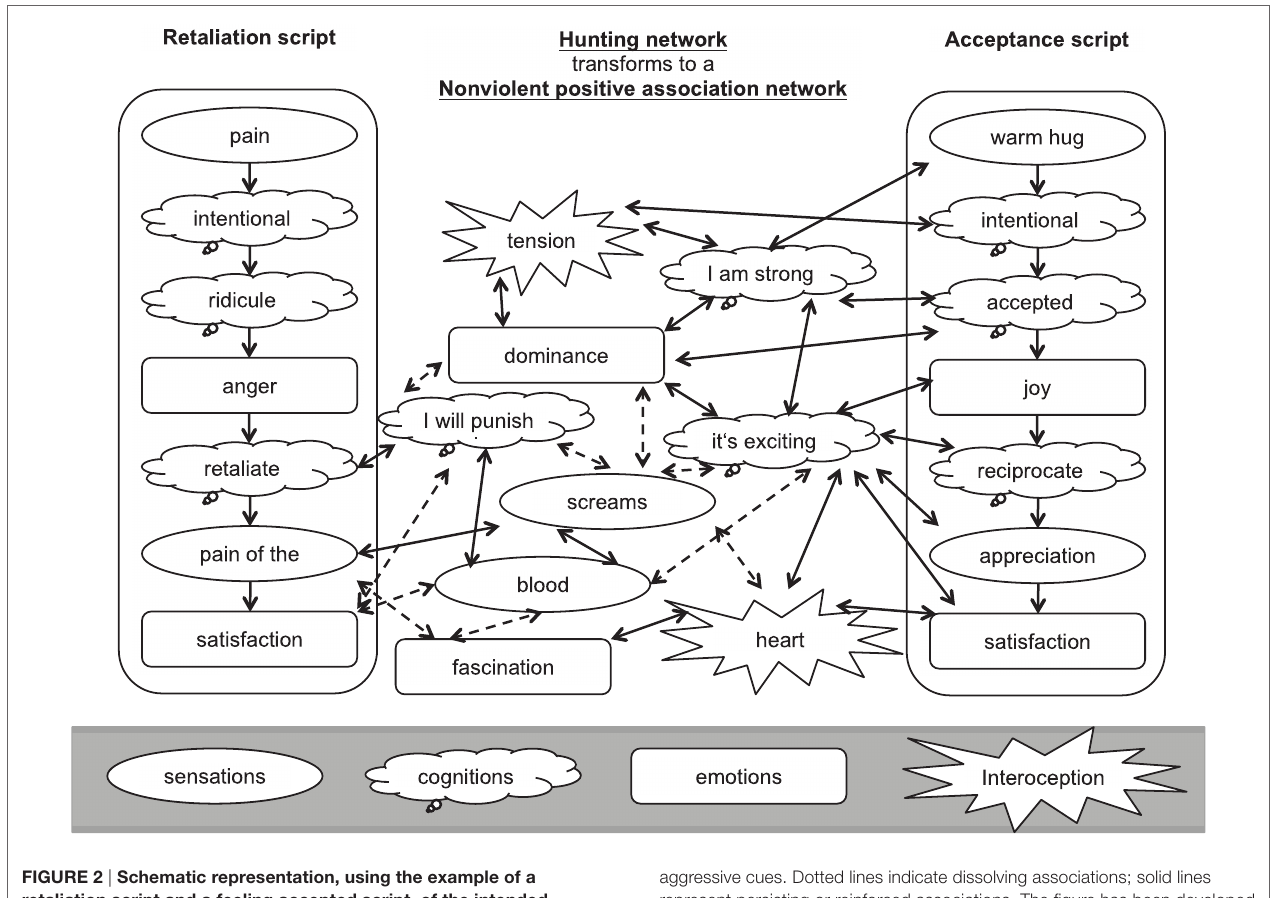
Figure 2 | schematic representation, using the example of a retaliation script and a feeling accepted script, of the intended transformation of the hunting network into a positive association network . Exposing to and contextualizing violent events is supposed to reduce the strength of associations between positive emotions and